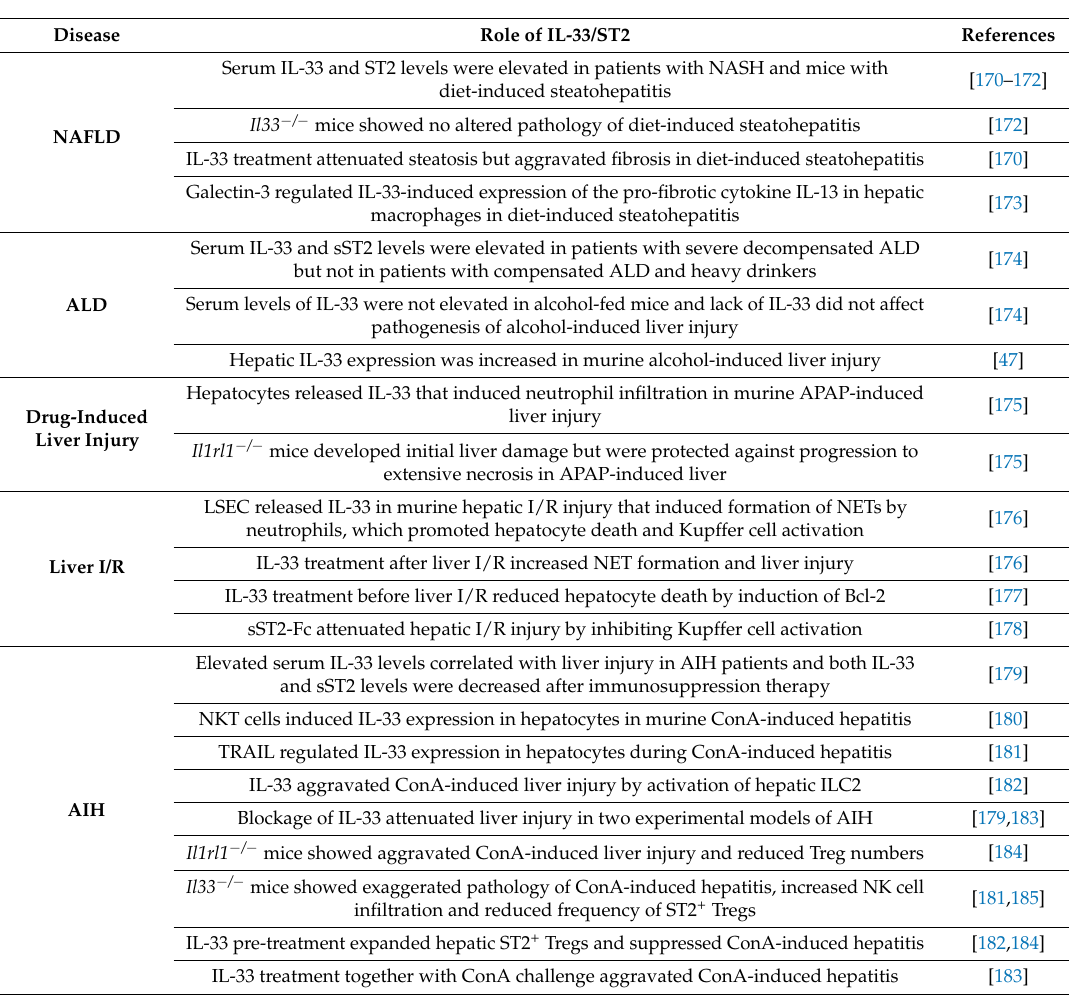
Table 3. Role of IL-33/ST2 in sterile liver